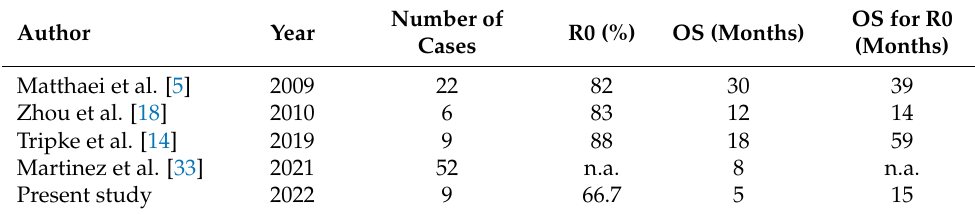
Table 3. Comparable studies of surgically treated